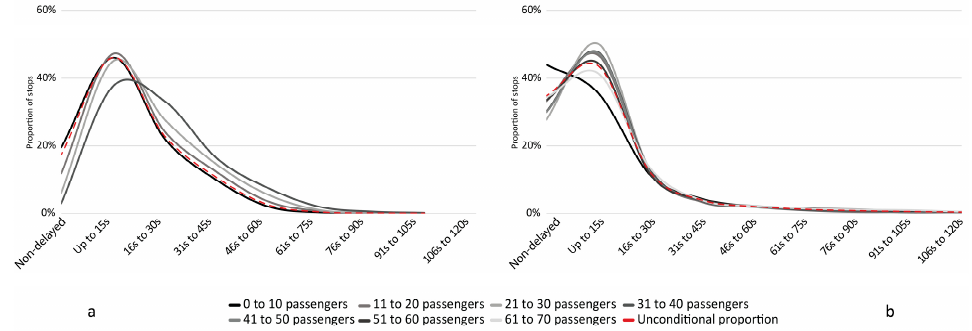
Figure 4. Proportion of dwell time delays for different passenger volumes for stations with a scheduled dwell time of 42 s ( a ) and 120 s ( b ).